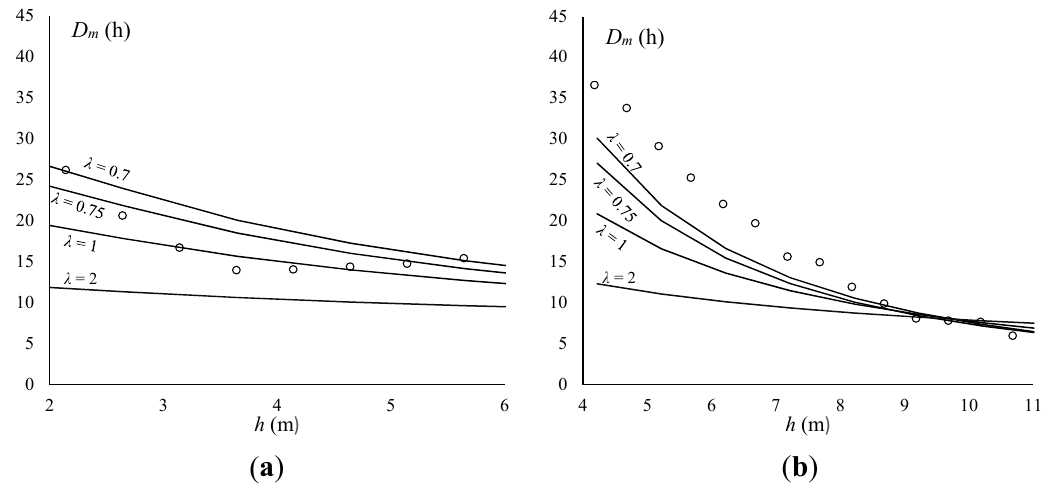
Figure 8. Comparison between mean persistence D m above the threshold h in actual sea (circles) and in EPSs (continuous lines) having various storm shapes λ : ( a ) the buoy 42001; and ( b ) the buoy